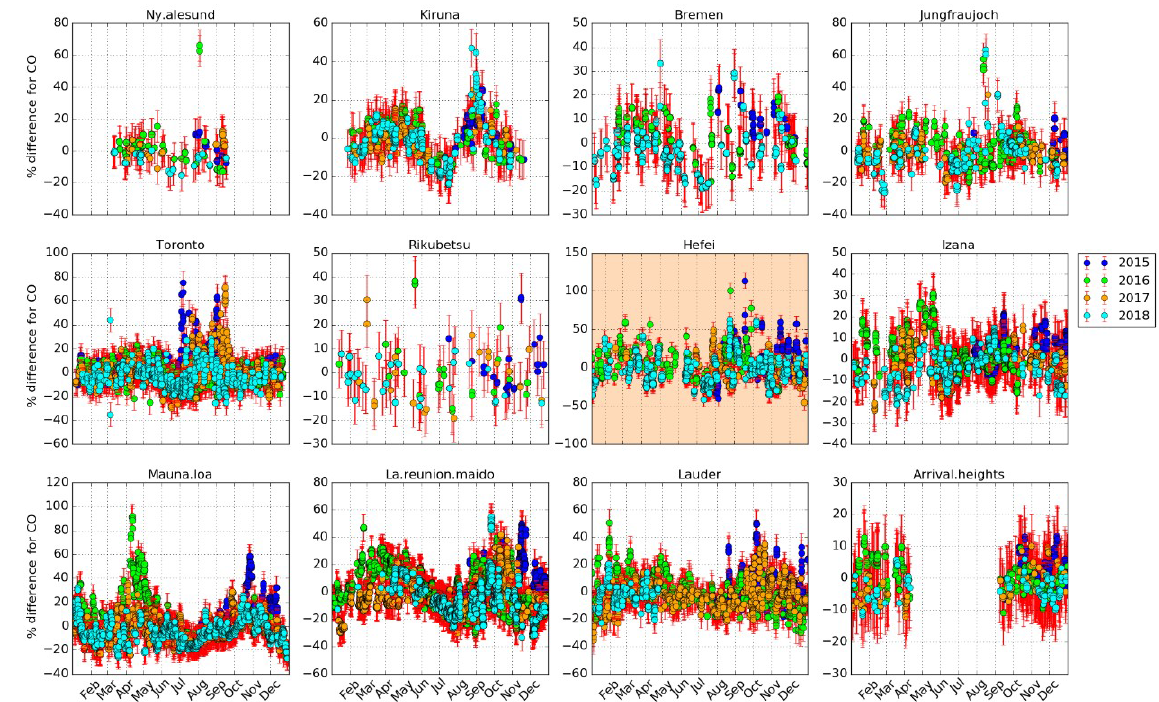
Figure 5. The same as Fig. 4 but for